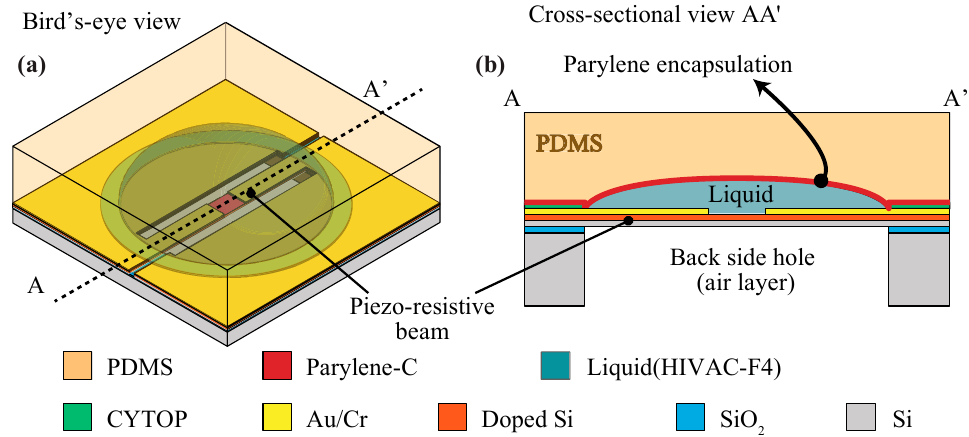
Figure 1. Schematic ( a ) bird’s eye and ( b ) cross-sectional view of super acoustic (SA) sensor. Abbreviations and products: PDMS, polydimethylsiloxane; HIVAC-F4, obtained from Shin-Etsu Silicones (Chiyoda-ku, Tokyo, Japan); CYTOP, obtained from Asahi Glass Co., Ltd. (Chiyoda-ku, Tokyo, Japan).